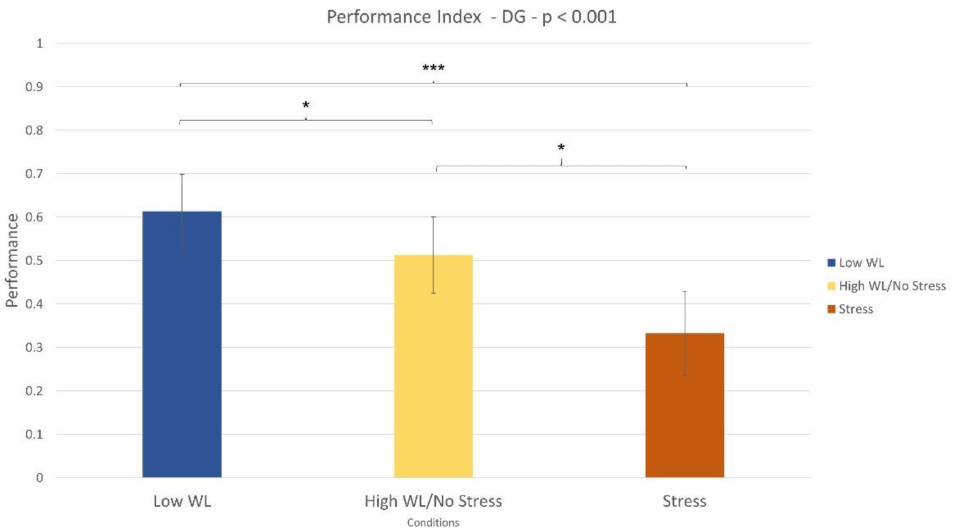
Figure 5. The performance index significantly decreased during the high WL condition compared to Low WL condition ( p = 0.03). The same result was found in the stress vs. no stress comparison ( p =